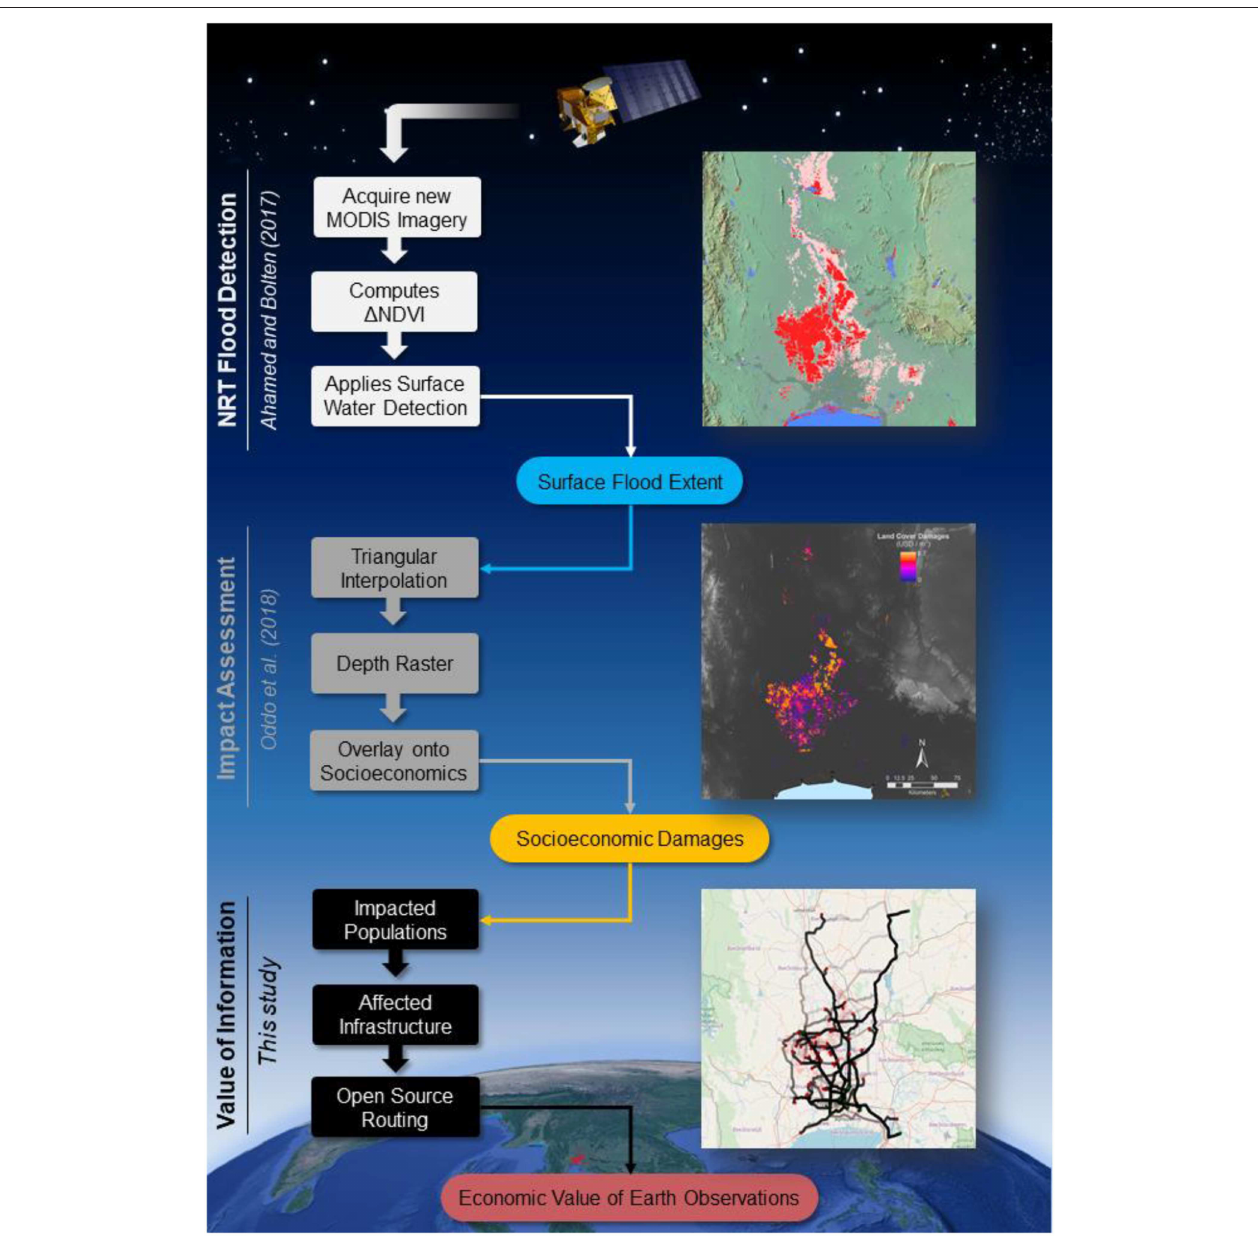
FIGURE 3 | Workflow for generating near real-time (NRT) routing information from Earth observations. MODIS imagery is ingested from LANCE server to produce surface water extents. Extents are digitized and used to estimate flood depths and damage estimates. Finally, these damages can be incorporated into the value of information analysis for emergency